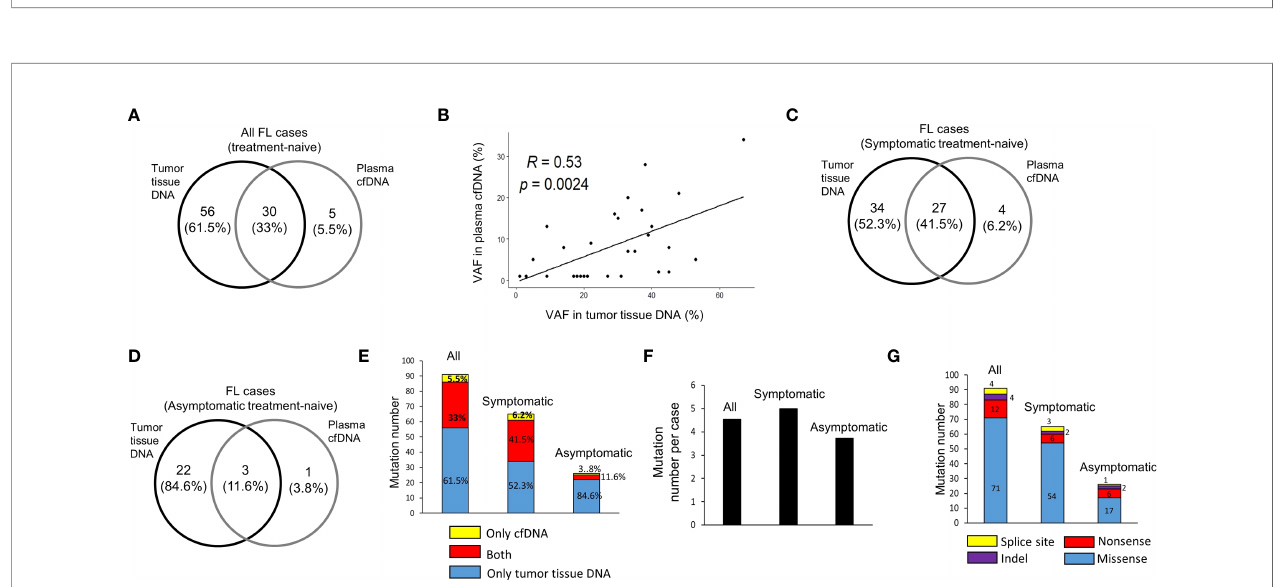
FIGURE 1 | The relationship between high plasma cfDNA concentrations and clinical variables in treatment-naive FL patients. Kaplan-Meier plots showing the relationship between high plasma cfDNA concentrations and overall survival (A) or progression-free survival (B) in treatment-naive follicular lymphoma patients. (C) Box-whisker plot comparing plasma cfDNA concentrations in symptomatic and asymptomatic FL patients. Linear regression graphics showing the relationship between plasma cfDNA concentrations and age (D) , Ki-67 index (E) , PET-CT positive region number (F) , SUVmax value (G) , and LDH levels (H)